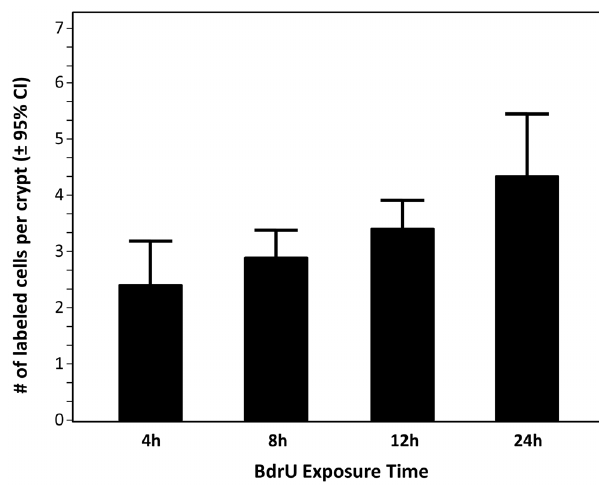
Figure 2. The number of labeled nuclei in a single midgut cross-section is a function of duration of exposure to BrdU. This presumably reflects the number of cell cycle events that occur during the exposure. To control for this effect, a standardized 24 h duration of exposure to BrdU via feeding was used in the main experiments that assessed the effects of xenobiotics on intestinal stem cell proliferation. The longer exposure time is also expected to increase the accuracy of ISC proliferation estimate, although the inter-individual variation among samples in this experiment was lower after 8 and 12 h.